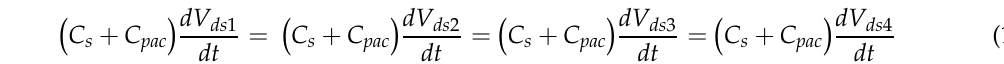
Figure 10. Simulation results of voltage-sharing performance between four series-connected SiC- MOSFETs in MSP. As can be seen, the MSP is not sensitive to C pac in terms of voltage sharing among the series- connected devices, as shown in Figure 10. Even for exacerbated values of C pac , the bus voltage is perfectly shared between the devices. The switching speed of the switching cell is also improved in the proposed MSP concept when compared to the traditional one. Figure 11 shows the dv/dt as a